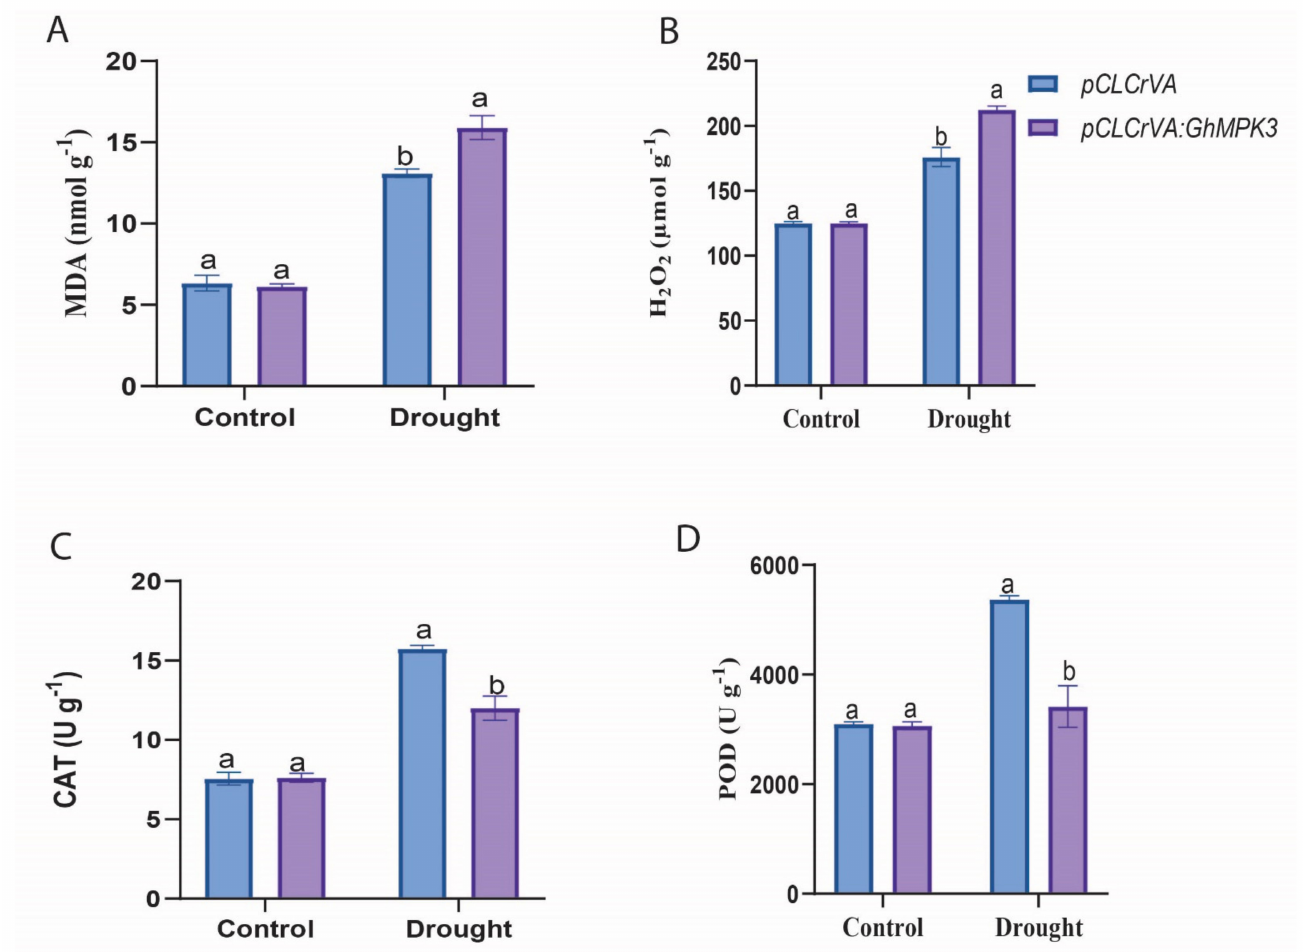
Figure 10. Enzyme activity analysis in GhMPK3 -VIGS and VA cotton plant leaf under drought stress conditions. ( A ) MDA, ( B ) H 2 O 2 , ( C ) CAT, and ( D ) POD plants after 10 days of control and drought treatment. Each experiment was conducted three times. The error bar represents the three biological replicates’ standard deviation. The significant differences between VA and GhMPK3 -VIGS plants (ANOVA; p < 0.05) are indicated by different letters a/b.